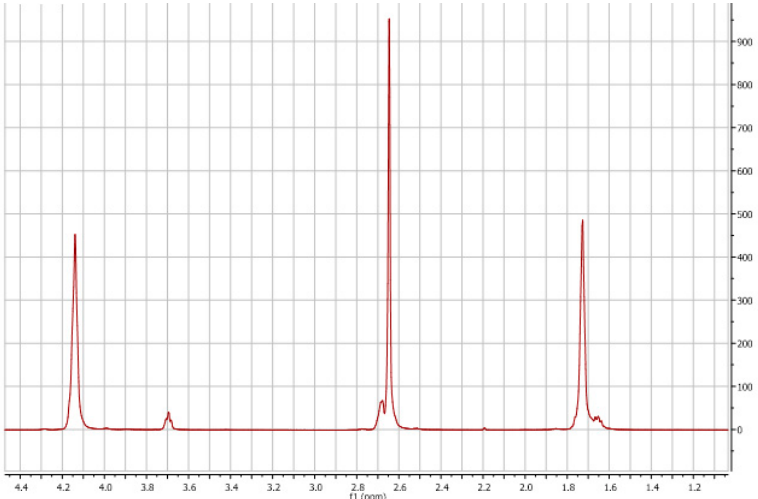
Figure 4. 1 H-NMR spectrum of synthesized bS Figure 4. 1 H ‐ NMR spectrum of synthesized bS polyol.